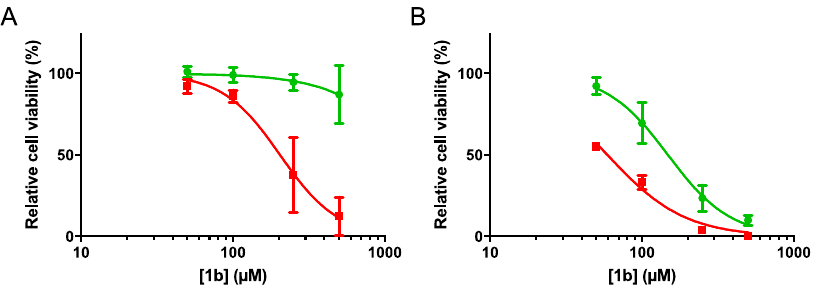
Figure 1. Relative cell viability (%) in ( A ) HT29 and ( B ) HCT116 cells exposed to increasing concentrations of the derivative 1b under normoxic (green) and anoxic (red) conditions. The data represent the average ± SEM of three independent biological repeats. Table 2. HCR of all compounds IC 50 N vs . IC 50 A.